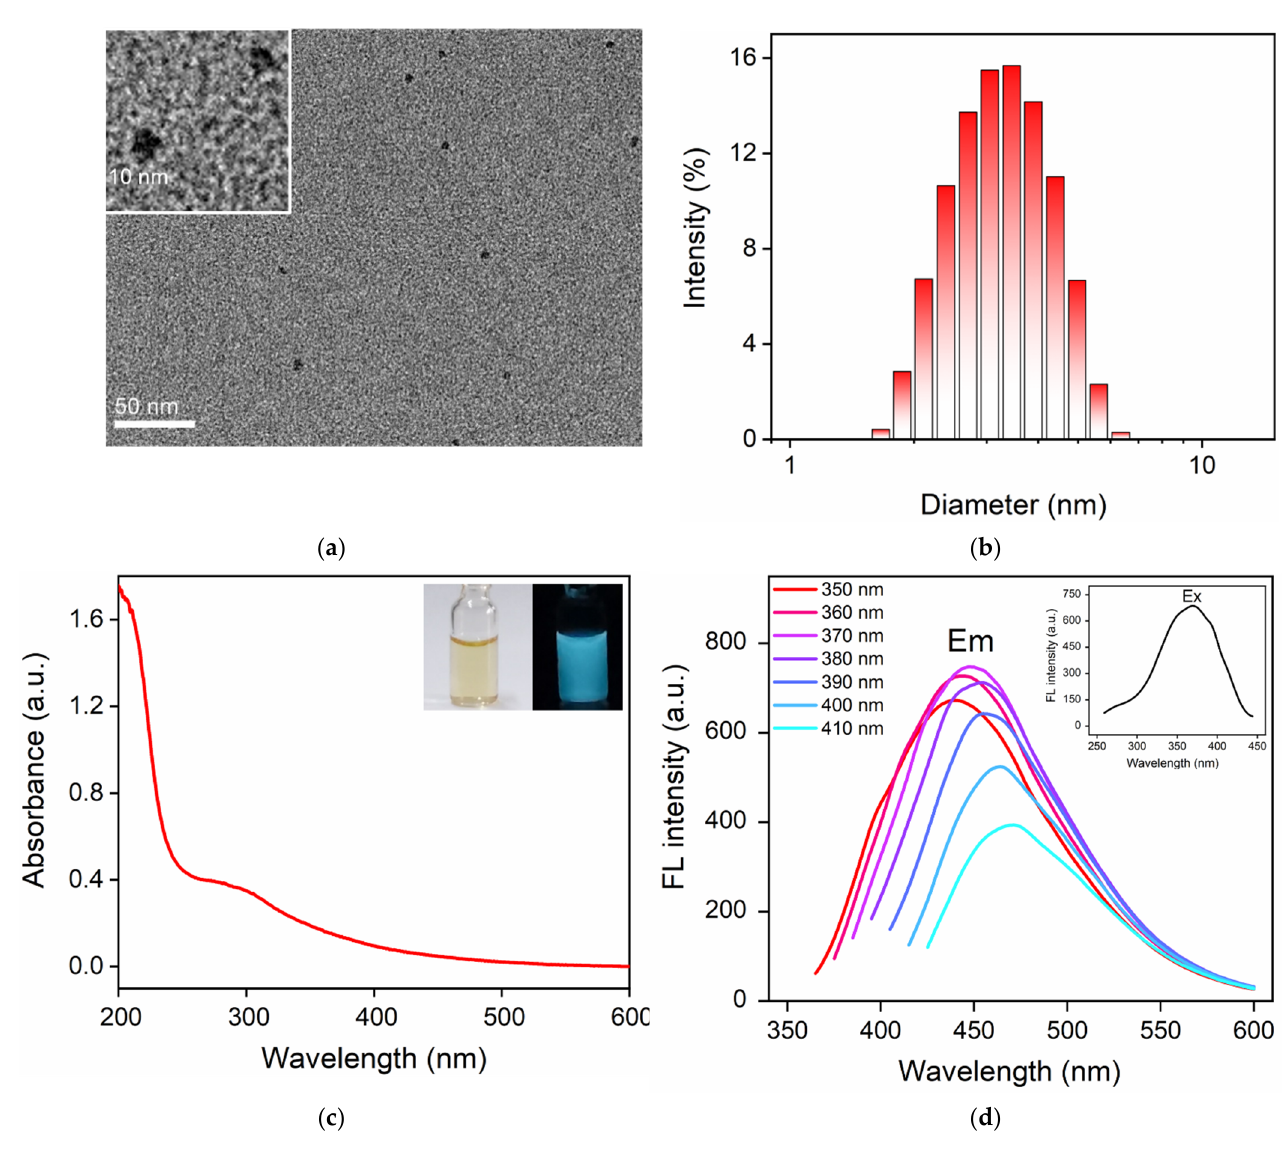
Figure 2. ( a ) TEM image of CDs. The inset is the high-resolution TEM (HRTEM) image. ( b ) The diameter distribution plot of CDs measured with DLS. ( c ) UV absorption spectra of CDs. Insets are optical images of CDs under daylight ( left ) or UV light ( right , 365 nm). ( d ) The fluorescence (FL) emission spectra (EM) of CDs obtained at different excitation wavelengths ranging from 350 nm to 410 nm (10 nm increments). Inset is the FL excitation spectrum (EX) obtained with an emission wavelength of 450 nm.